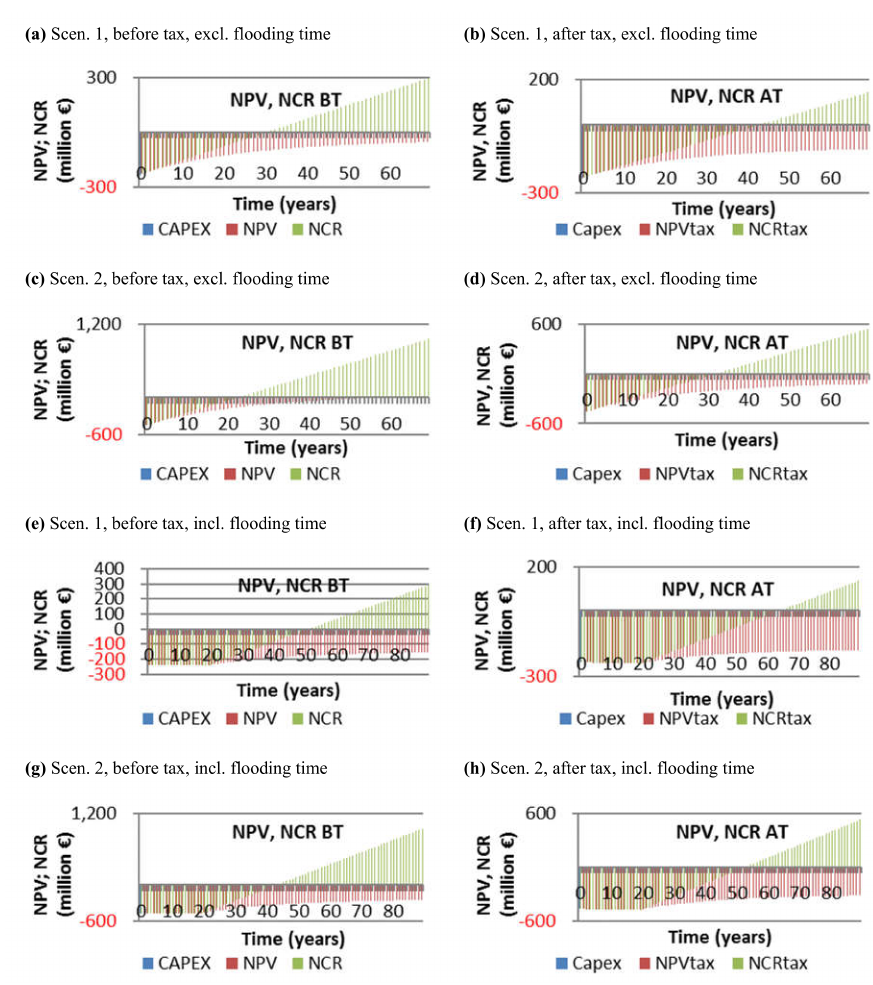
Figure A2. Capex and net present value and net cash recovery before and after tax; excluding (plots ( a – d )) and including (plots ( e – h )) flooding time, Scen. 1 and